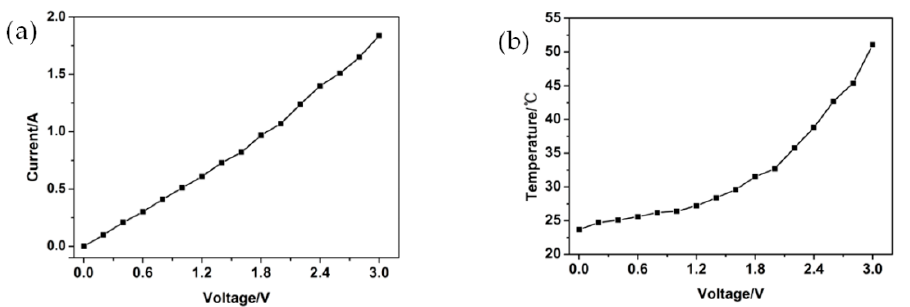
Figure 5. Electro-thermal performance of heating system: ( a ) current as function of applied voltage, ( b ) T max versus the applied voltages. ( b ) T max versus the applied